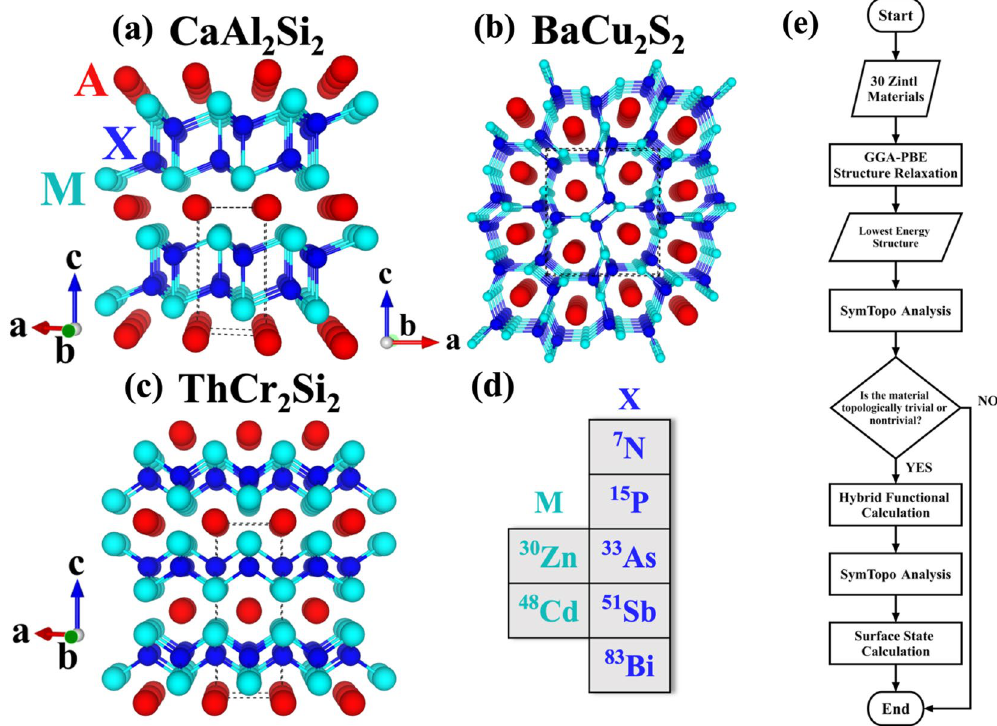
Figure 1. Three possible structures of bulk AM 2 X 2 : ( a ) CaAl 2 Si 2 -type (P 3 m1, 164) ( b ) BaCu 2 S 2 -type (Pnma, 62) ( c ) ThCr 2 Si 2 -type (I4/mmm, 139). ( d ) The list of elements used in this exhaustive materials search. M and X are, Group IIB, and Group VA, respectively. ( e ) The flow chart of our search for identifying the topological